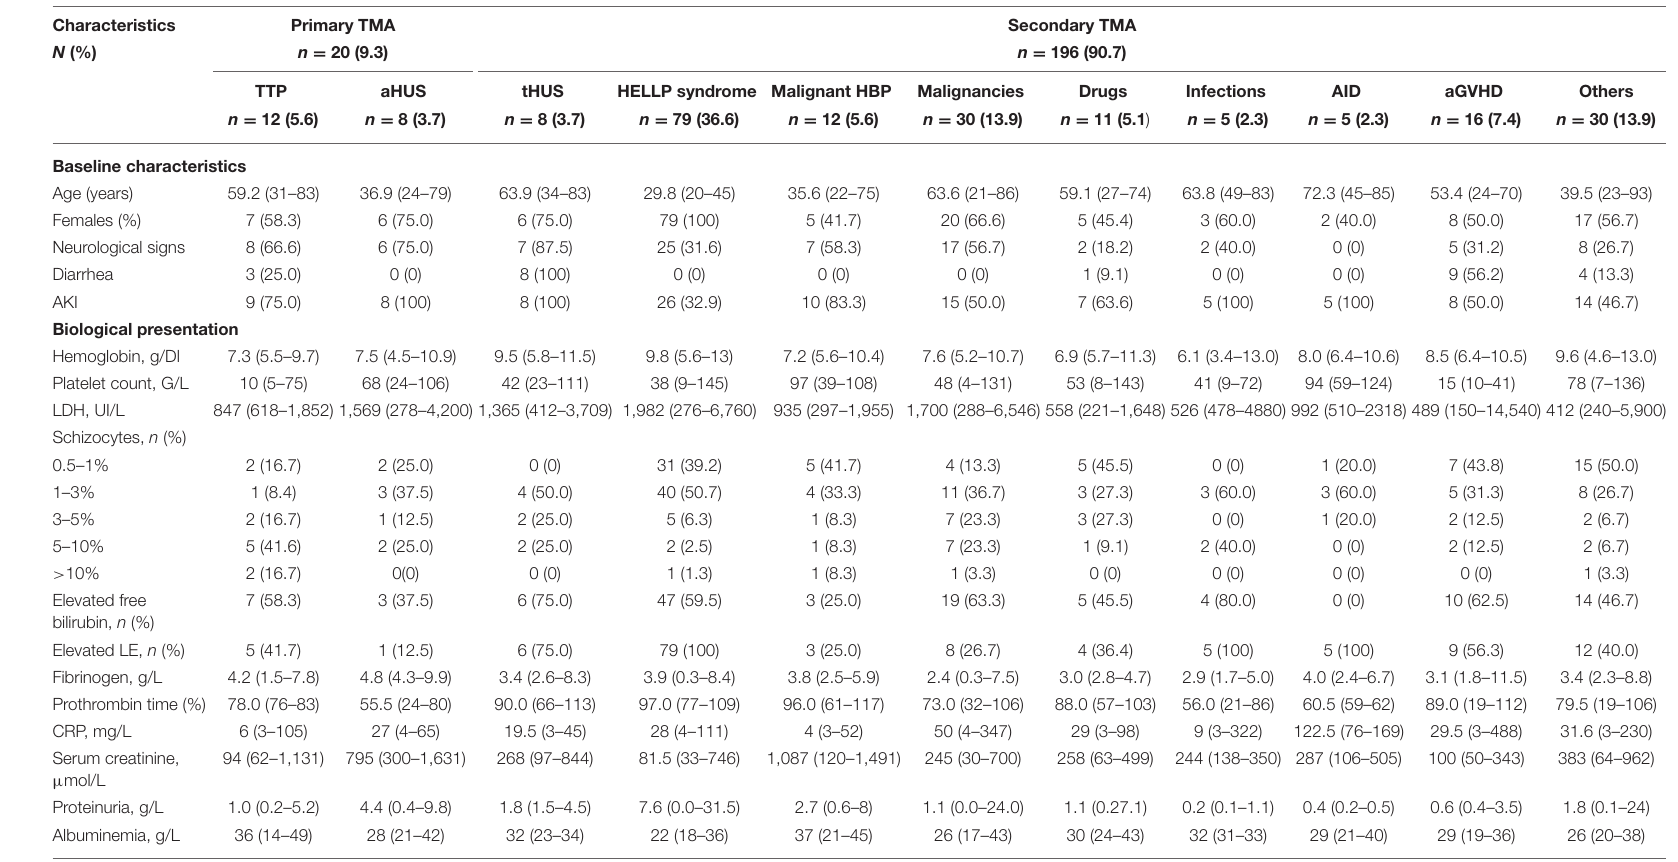
TABLE 1 | Clinical and biological presentation of TMA according to